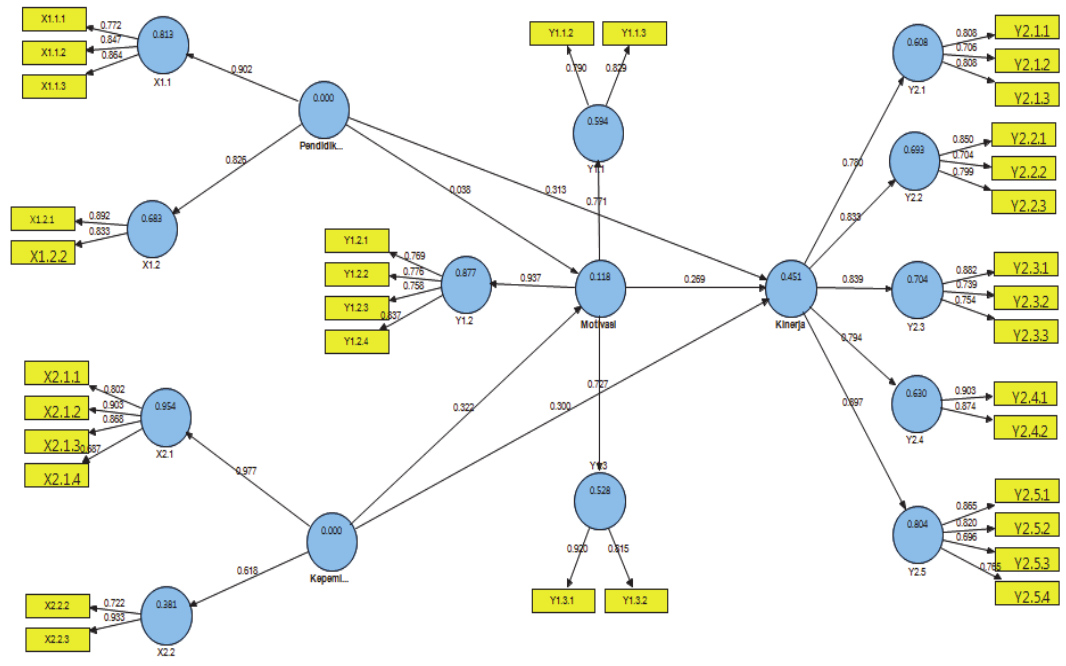
Fig. 2. Structural Equation Modeling Results